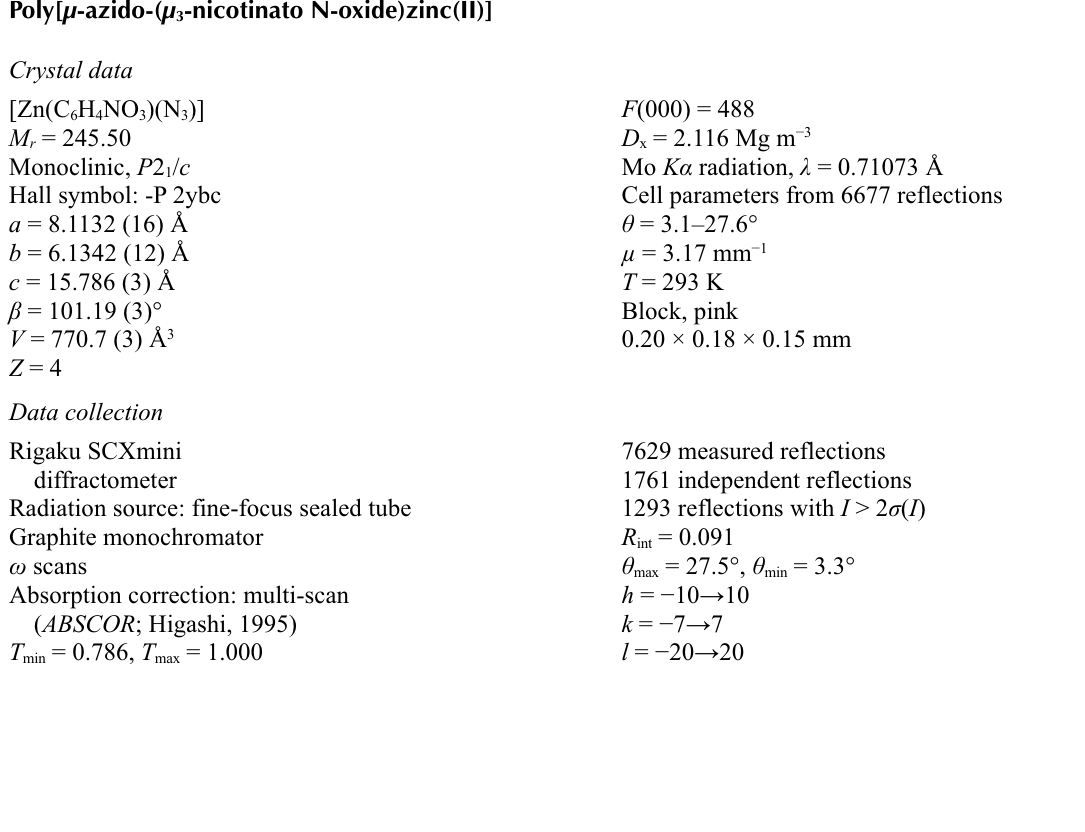
A partial view of the title compound showing the coordination of Zn atom with the atom-labelling scheme. Ellipsoids are drawn at the 30% probability level. H atom have been omitted for clarity. [ Symmetry codes: (i) -x+2, y+1/2, -z+3/2; (ii) - x+2, -y+2, -z+2; (iii) x, -y+3/2, z-1/2; (iv) x, -y+3/2,